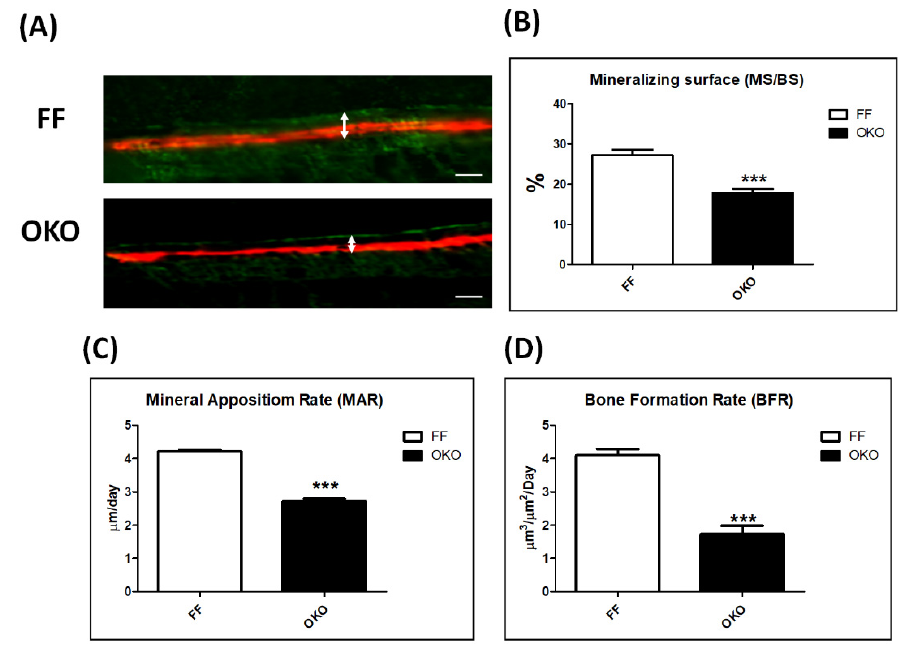
Figure 3. Decreased bone formation rate in the femurs of DDR1 knockout mice. ( A ) Representa- tive calcein and alizarin red S labeling images demonstrating cortical bone formation in the cortical endosteum of the distal femora of 12-week-old FF/OKO mice. The white arrow points to the label of the distance between calcein (Green) and alizarin red S (Red) dyes in a time interval of 28 days. Quantitation of dynamic histomorphometry parameters of periosteum, including ( B ) the mineralized over bone surface (MS/BS), ( C ) the mineral apposition rate (MAR), and ( D ) the bone formation rate (BFR) in the distal femur metaphysis of FF and OKO mice. The representative images of fluorochrome marker labels are shown with scale bars of 50 µ m. In the quantitative analysis, each bar represents the mean ± SE of six samples in each group (*** p < 0.001 versus FF